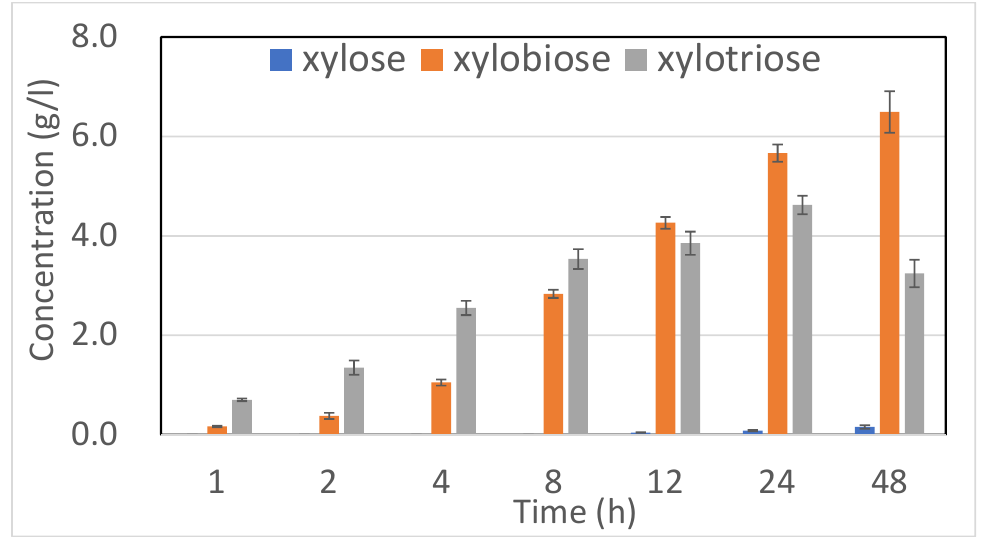
Figure 4. Time course of XOS production from EFB when using nonrecombinant endo-1,4- β -xylanases. The enzyme dose was 2 U/mL. Each error bar represents the standard deviation of triplicate experiments.